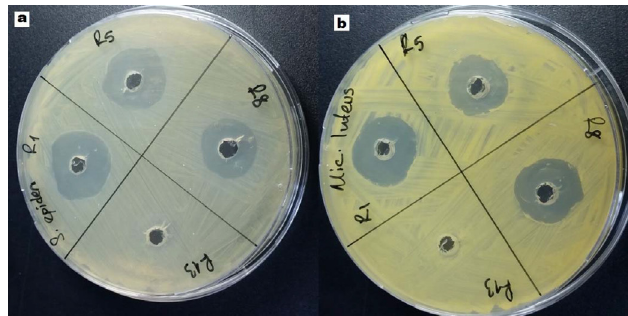
FIGURE 2 - a - Effects of compounds 1 (R1), 2 (R5), 3 (R8), 11(R13) against Stapylococcus epidermidis ATCC 12228. b - Effects of compounds 1 (R1), 2 (R5), 3 (R8), 11(R13) against Micrococcus luteus ATCC 9341.